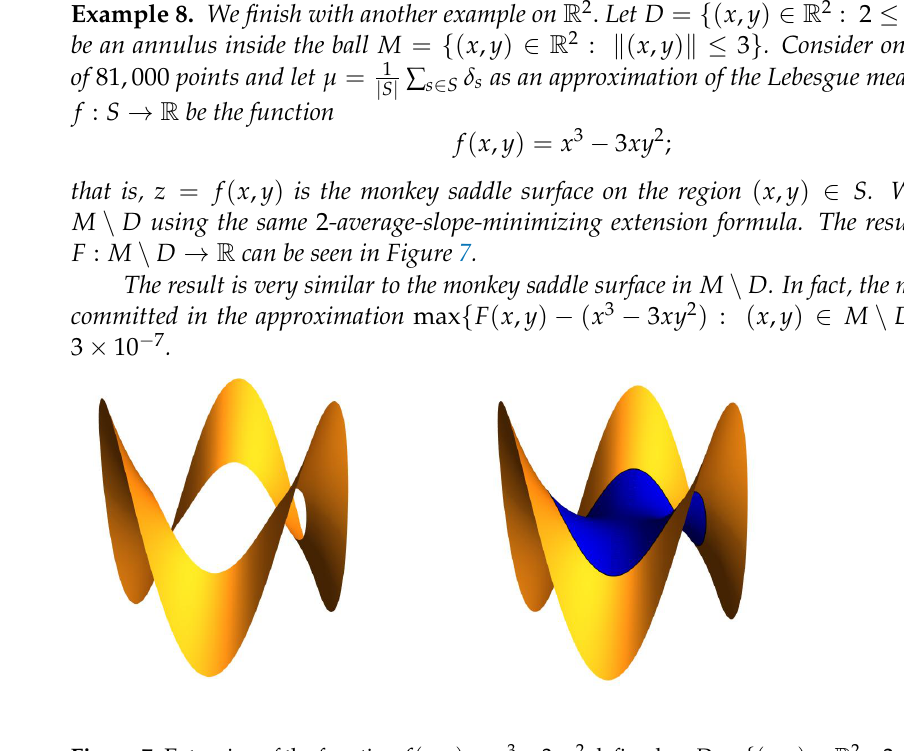
Figure 7. Extension of the function f ( x , y ) = x 3 − 3 xy 2 defined on D = { ( x , y ) ∈ R 2 : 2 ≤ (cid:107) ( x , y ) (cid:107) ≤ 3 } using the 2-average-slope-minimizing